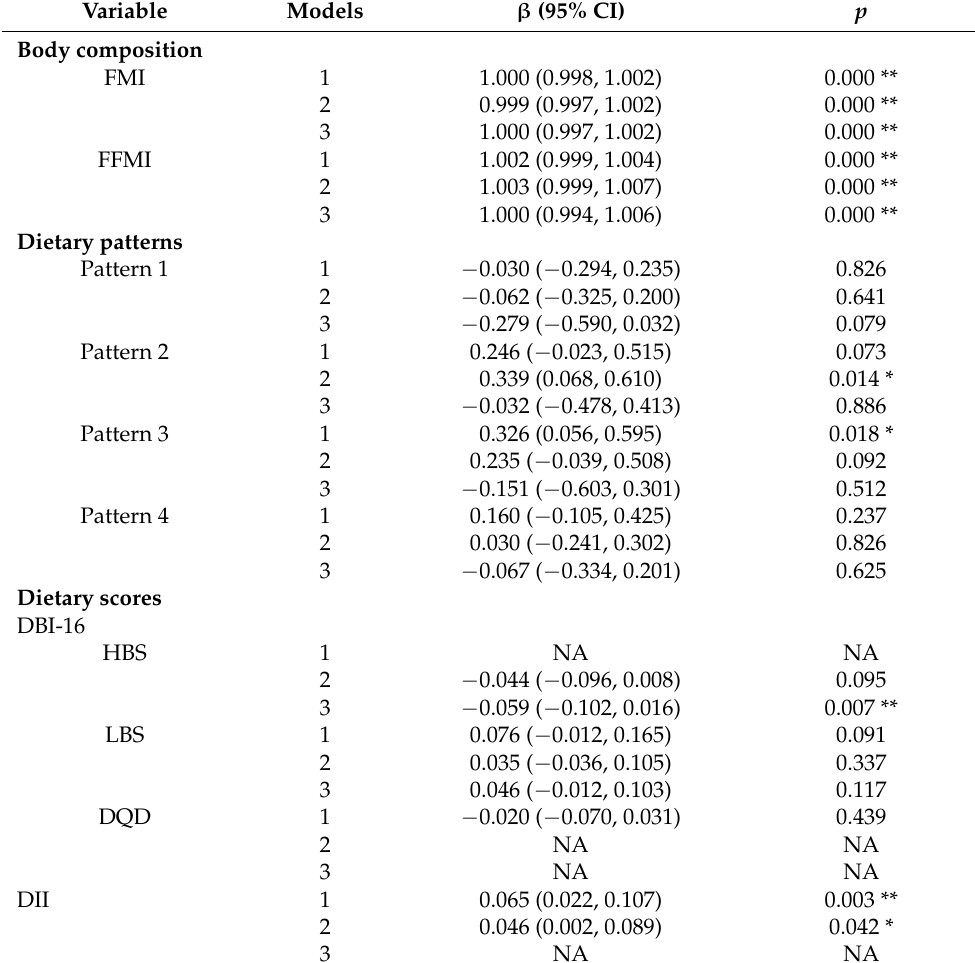
Table 4. The association of body composition, dietary scores, and dietary patterns with